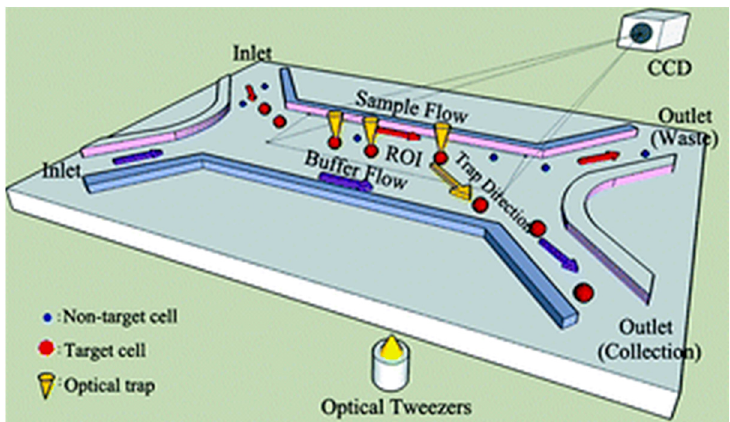
Figure 13. Schematic representation of the cell sorting procedure. Reproduced from [94] with permission of The Royal Society of Chemistry.